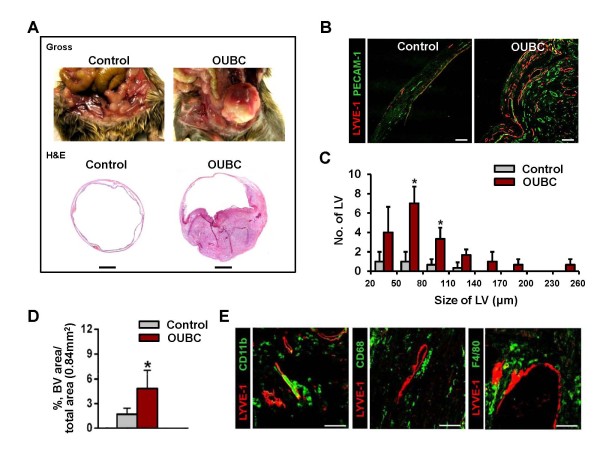
OUBC presents profound lymphangiogenesis, angiogenesis and CD11b+/CD68+ TAM infiltration. PBS (Control) or 1 × 106 MBT-2 cells (OUBC) were injected into the urinary bladders of 8-10-week old female C3H mice. 4 weeks after PBS or the tumor cell injection, the bladders were harvested and stained. (A) Photos and images showing gross features and sections (H&E stained) of bladders. Scale bars, 2 mm. (B) Images showing LYVE-1+ lymphatic vessels (LV) and PECAM-1+ blood vessels (BV). Scale bars, 100 μm. (C) Comparison of LV numbers at different sizes of LV in the bladder sections. Graph shows mean ± SD; n = 5 for each group. *p < 0.05 versus Control. (D) Comparison of blood vessel densities (BVD) per total sectioned area (0.84 mm2) of bladder. Graph shows mean ± SD; n = 5 for each group. *p < 0.05 versus Control. (E) Images showing CD11b+, CD68+ and F4/80+ TAM infiltrated near LYVE-1+ lymphatic vessels in OUBC. Scale bars, 100 μm.